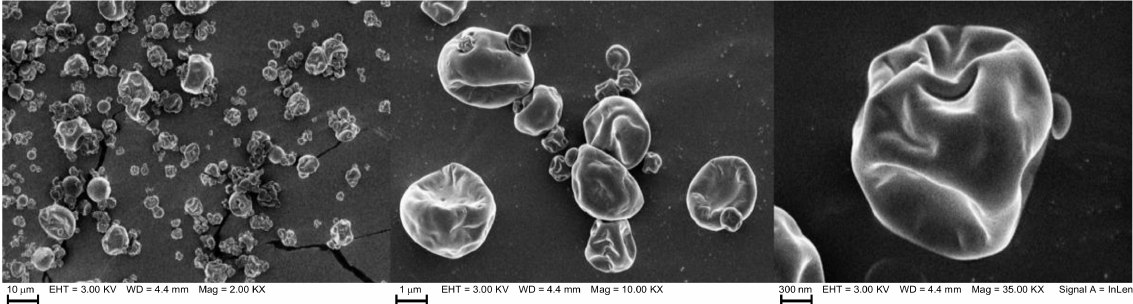
Figure 1. Scanning electron microscopy (SEM) from microencapsulated oil of sacha inchi ( P. huayl- labambana ) with GA +CCSE (110 ppm) + MSE (110